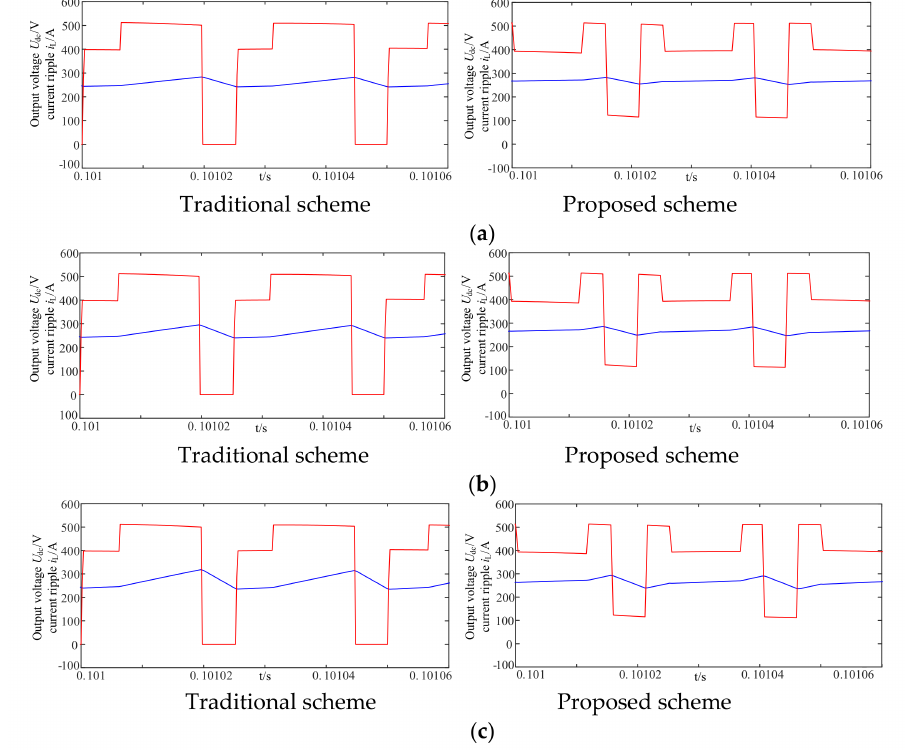
Figure 11. Rectifier bridge output voltage and inductor current ripple. ( a ) Inductance with 2 mH ( b ) Inductance with 1.5 mH ( c ) Inductance with 1